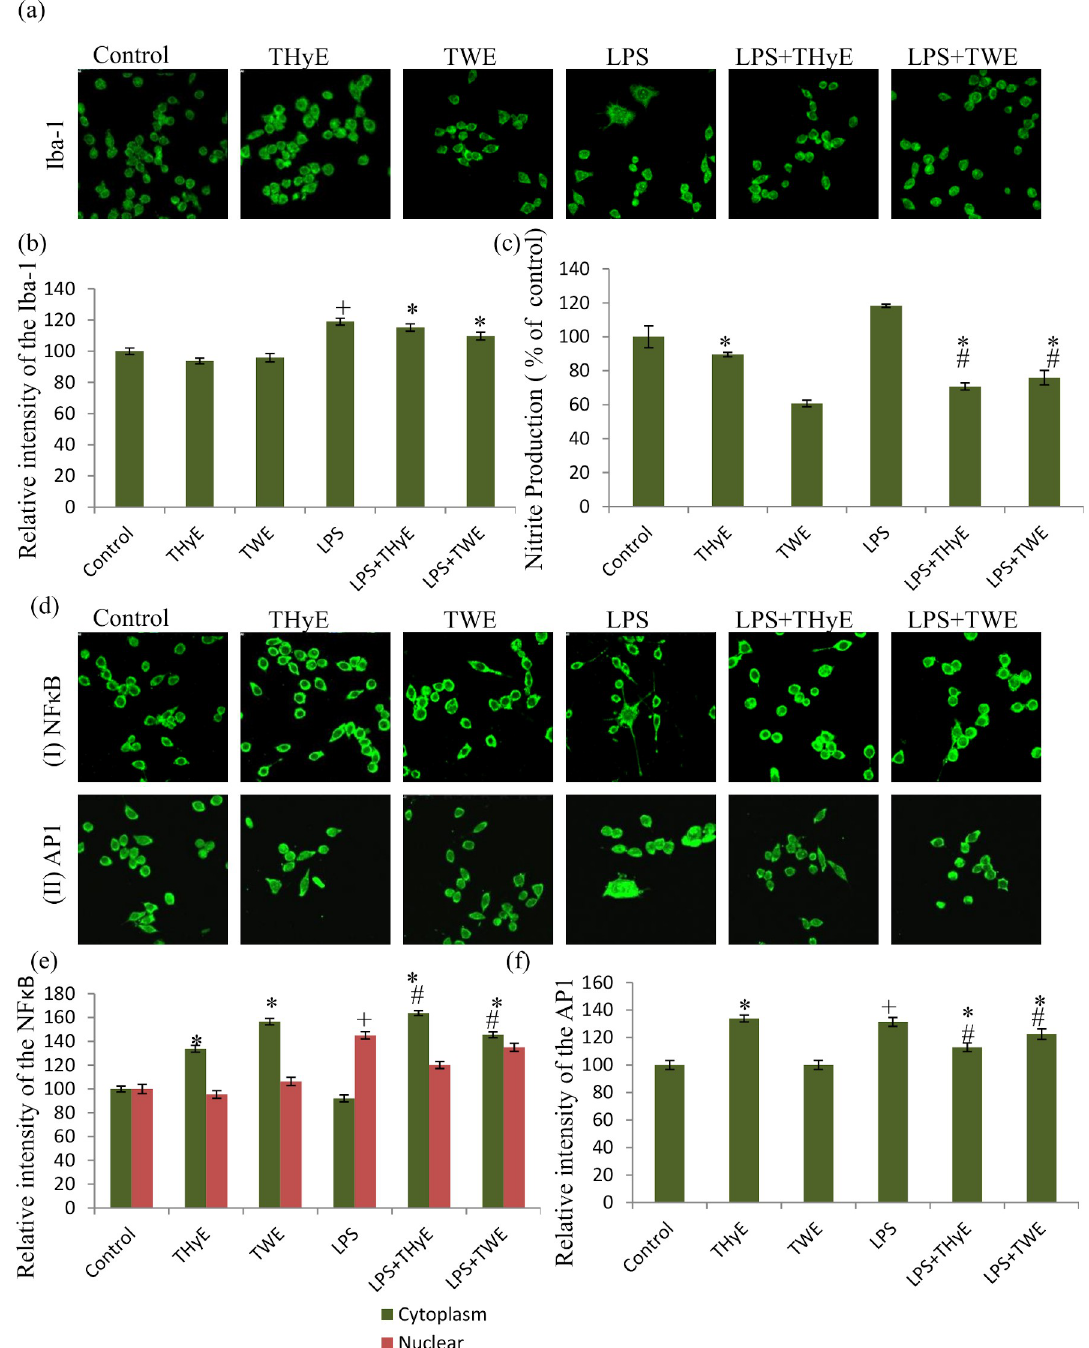
Fig 3. THyE and TWE inhibited microglial activation, nitrite production and expression of inflammatory proteins. (a) Confocal images of Iba-1 immunostaining of the BV-2 microglial cells pretreated with THyE (0.2 μ g/mL) and TWE (20 μ g/mL) with or without activation with LPS. (b) Histogram depicting the relative optical intensity of Iba-1 in BV-2 microglial cells among the different treated groups. (c) Histogram presenting the relative production of the nitrite in microglial conditioned media among different treated groups as estimated by the Griess Reagent. (d) Representative confocal images of NF κ B and AP1 immunostaining of the BV-2 microglial cells pretreated with THyE (0.2 μ g/mL) and TWE (20 μ g/mL) with or without activation with LPS. (e) Histogram depicting the relative cytoplasmic and nuclear expression of NF κ B in BV-2 microglial cells among the different treated groups. (f) Histogram depicting the relative optical intensity of AP1 in BV-2 microglial cells among the different treated groups. Images were captured using A1R Nikon Confocal laser scanning microscope at 60X objective magnification (Scale bar 50 μ m). + p � 0.001 represents statistically